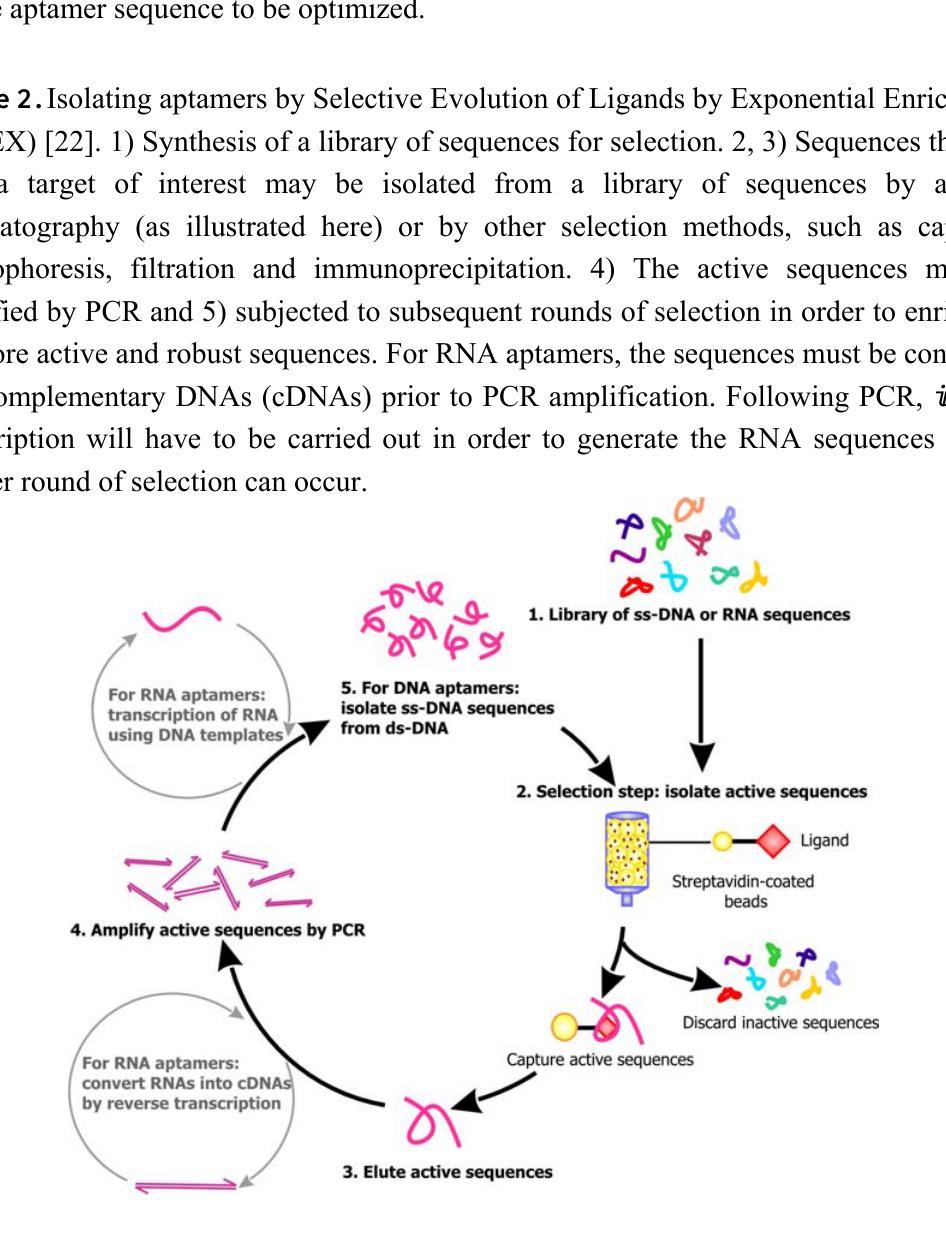
Figure 2. Isolating aptamers by Selective Evolution of Ligands by Exponential Enrichment (SELEX) [22]. 1) Synthesis of a library of sequences for selection. 2, 3) Sequences that